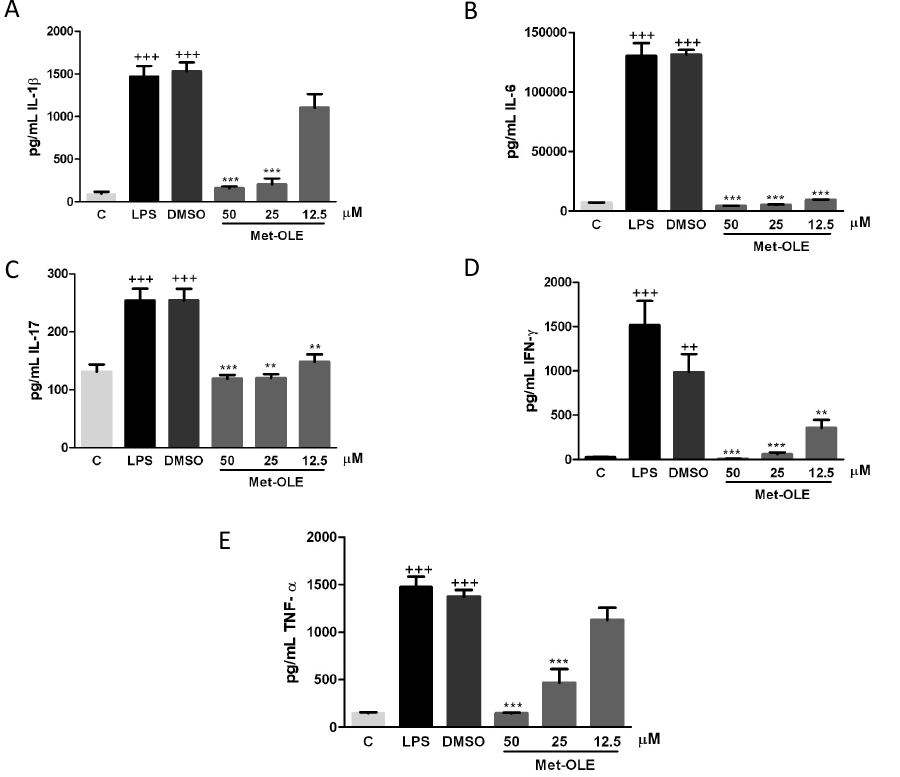
Figure 3. Pro-inflammatory cytokine levels were down-regulated in met-OLE treated cells. Macrophages were pretreated with met-OLE (50, 25 or 12.5 µ M) for 30 min and then, LPS-stimulated during 18 h. ( A ) IL-1 β , ( B ) IL-6, ( C ) IL-17, ( D ) IFN- γ and ( E ) TNF- α levels were measured by ELISA on cell supernatants. Results are presented as the mean ± SEM of at least six independent experiments. ++ p < 0.01; +++ p < 0.001 vs. unstimulated control cells; ** p < 0.01; *** p < 0.001 vs. LPS-DMSO stimulated cells.